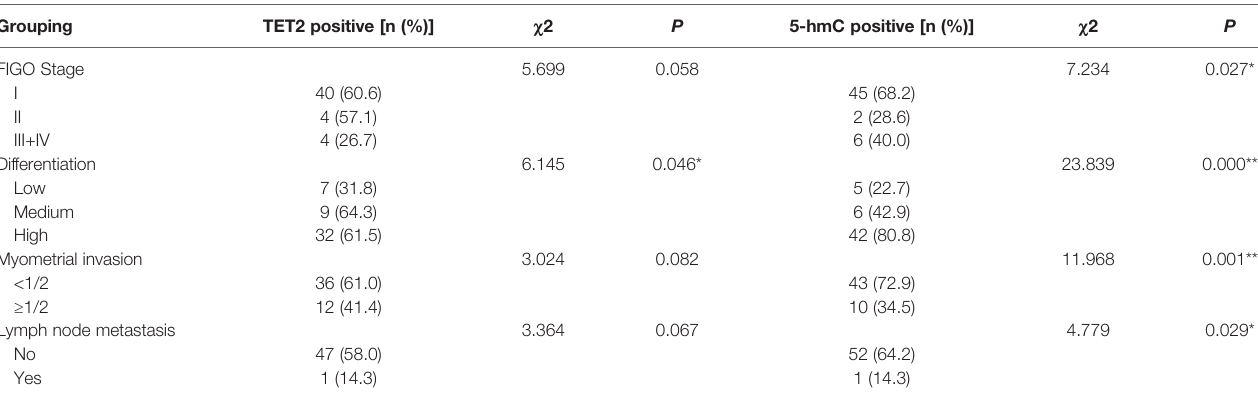
TABLE 1 | Relationships between TET2, 5-hmC and clinicopathological factors in EC. Grouping FIGO Stage